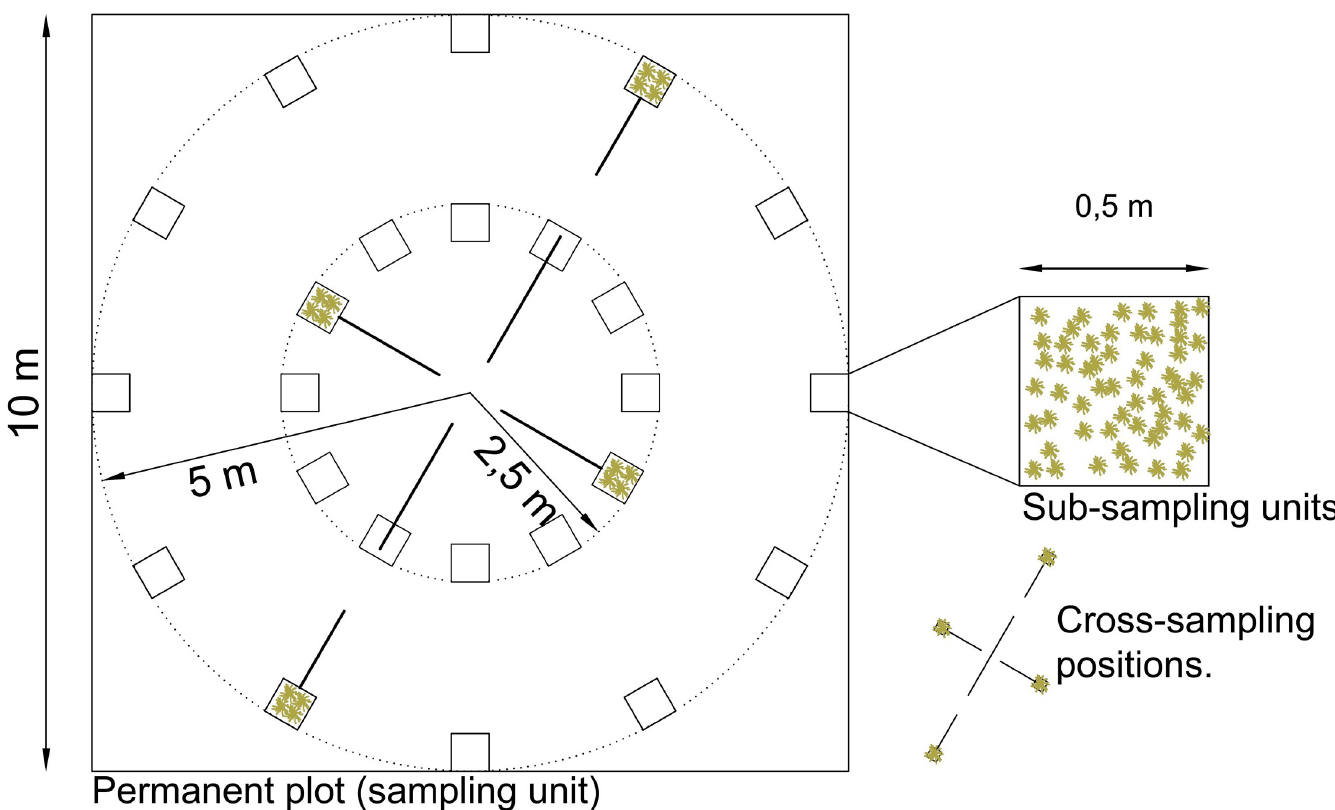
Fig 3. Sampling design in each permanent plot (sampling unit). Four sub-sampling units (filled boxes) are sampled in each census following the cross-sampling